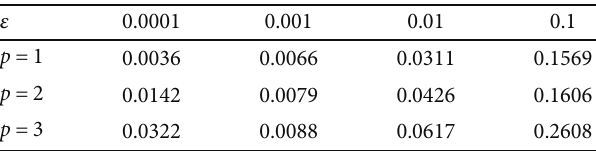
Table 2: The relative mean square errors at y = 0 : 6 for various noisy levels with k = 1 : 2